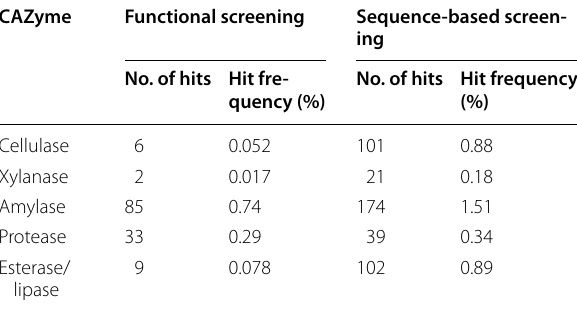
Table 1 Number of positive hydrolase hits from func- tional and sequence-based screening of the oil reservoir metagenomic library CAZyme Functional screening Sequence‑based screen‑